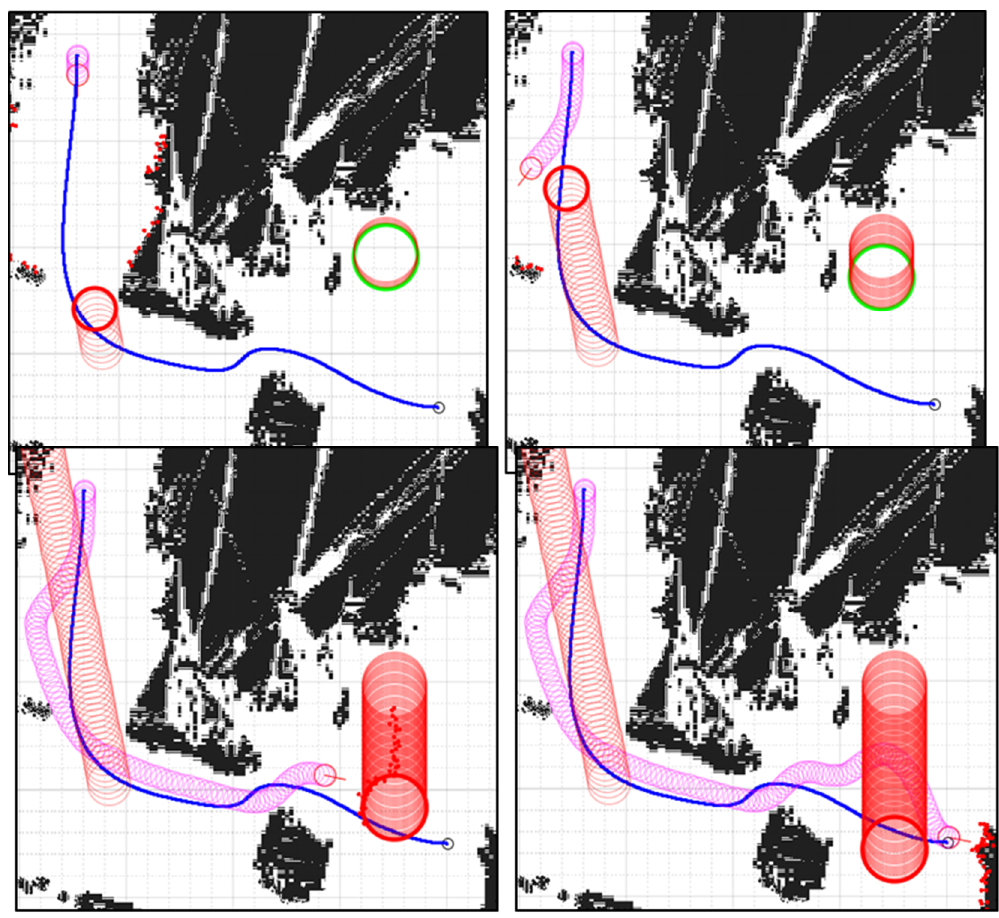
Figure 23. Reference trajectory of the robot is the blue curve, detected obstacle has red circular boundary, non-observed obstacle has green circular boundary.